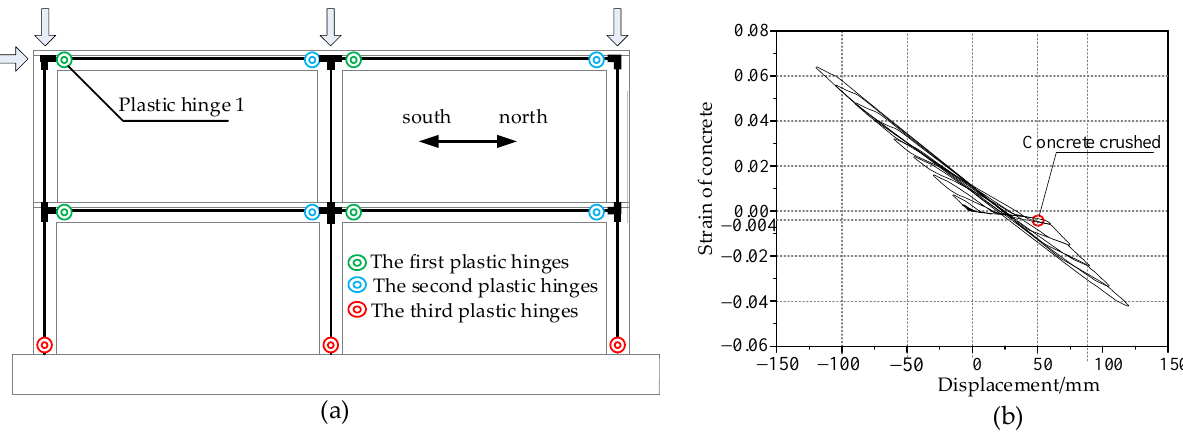
Figure 8. ( a ) The occurrence order of plastic hinges; ( b ) the relationship between structural displace- ment with strain of concrete at plastic hinge 1.